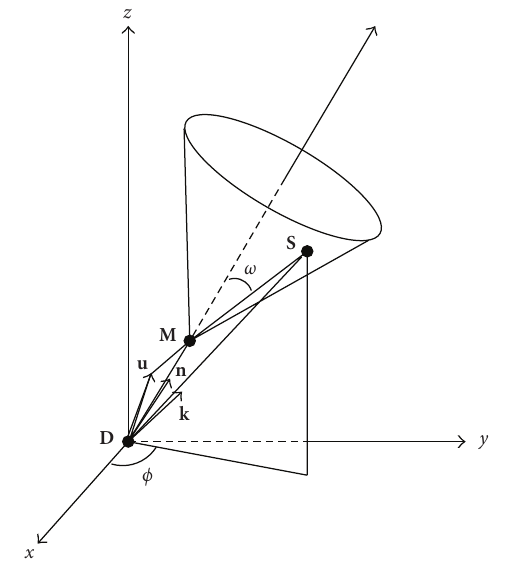
Figure 6: C 2 -cone and C 2 -conical Radon transform